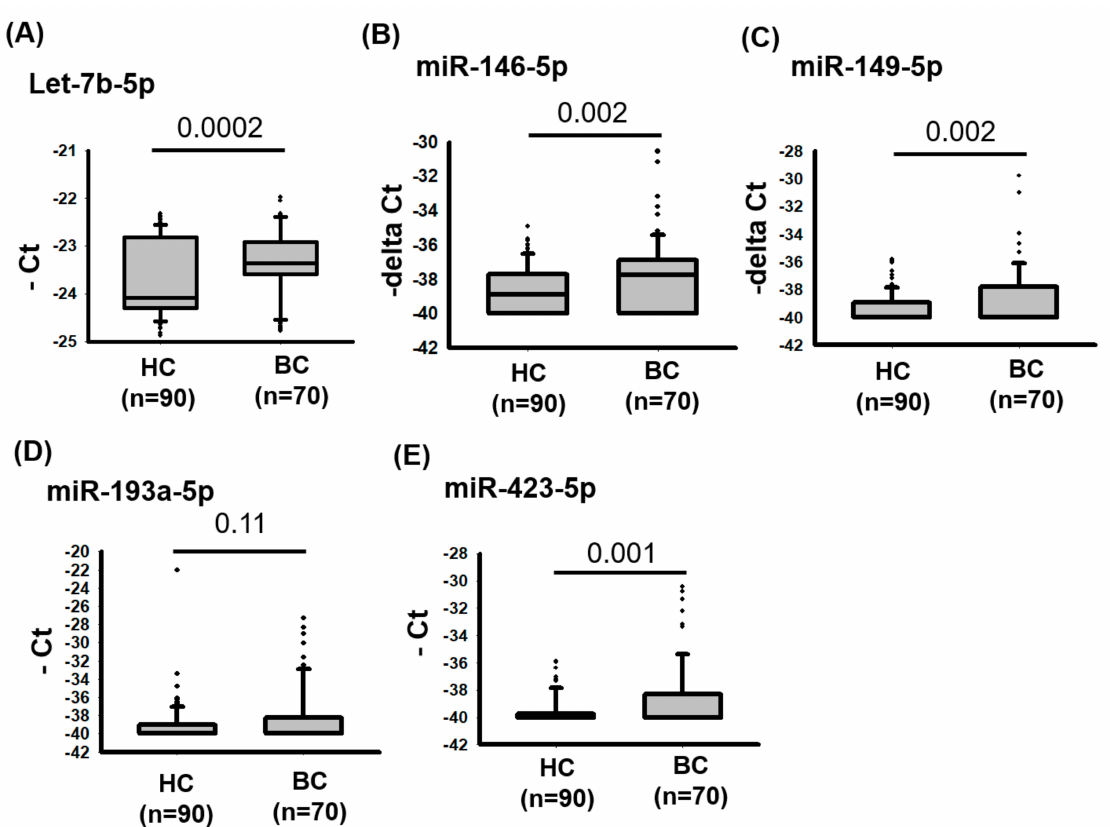
Figure 4. Expression levels of let-7b-5p , miR-146a-5p , miR-149-5p , miR-193a-5p , and miR-423-5p in urine from healthy controls and patients with bladder cancer. Relative levels of ( A ) let-7b-5p , ( B ) miR-146a-5p , ( C ) miR-149-5p , ( D ) miR-193-5p , and ( E ) miR-423-5p were examined in urine from 90 healthy controls and 70 patients with bladder cancer using TaqMan real-time PCR